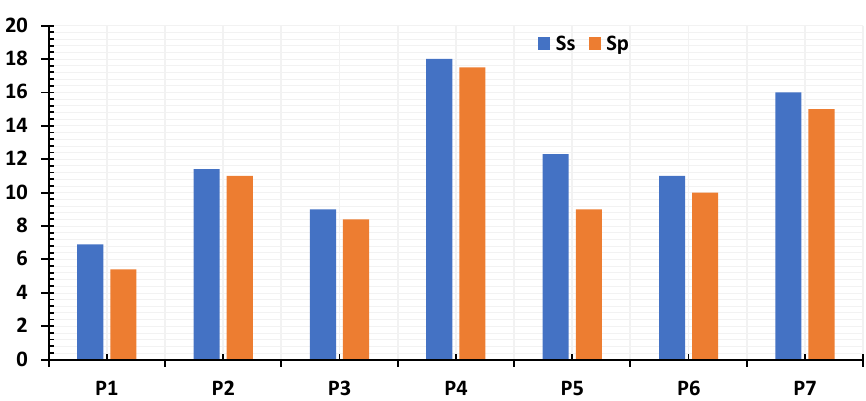
Figure 3. Seasonal variations in well depth (Ss is the dry season and Sp is the rainy season). The values of the piezometric levels are between 706 (P3) and 718 m (P6) during the dry season with a standard deviation of ∓ 3.63 m, and between 706.6 (P3) and 719 m (P6) during the rainy season with a standard deviation of ∓ 4.09 m. The averages of the piezometric level of the various wells obtained in the dry season and the rainy season are, respectively, 711.8 ± 4.2 and 712.9 ± 4.2 m. The average piezometric levels are